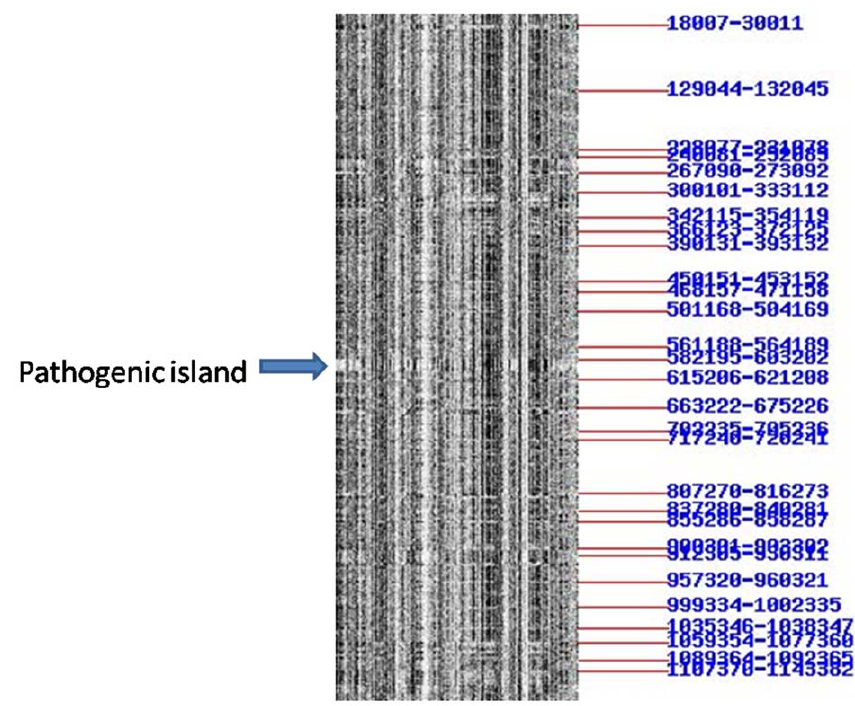
Figure 2. Barcode with detected abnormal pieces for E.coli O157:H7 EDL933.